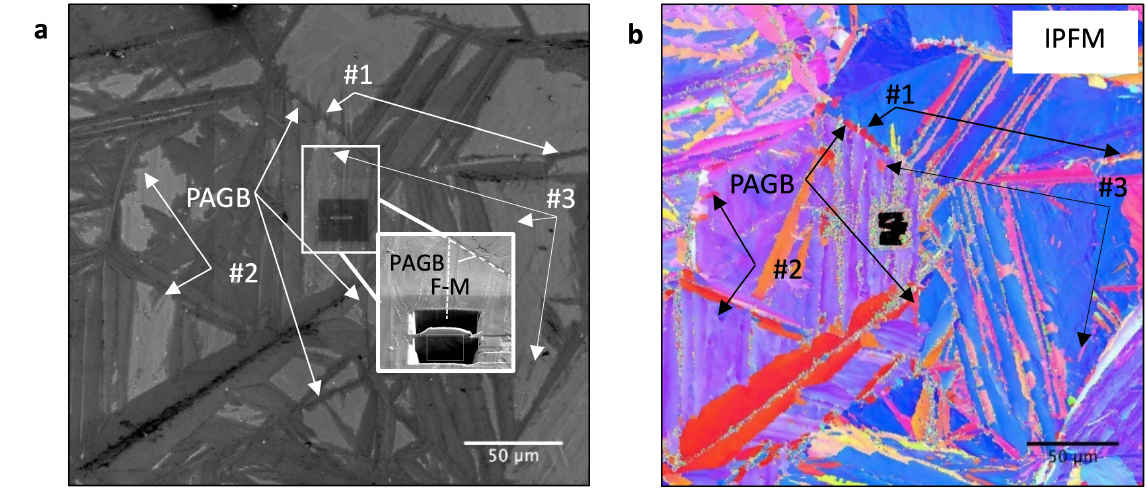
Figure 1. ( a , b ) Scanning electron microscopy (SEM) and IPFM images after the same Q&P heat treatment (HT) (as in Figure 2) performed with a high temperature laser scanning microscope [20]. The magnification in ( a ) indicates the removal position of the lamella used here for further more in-depth investigations.